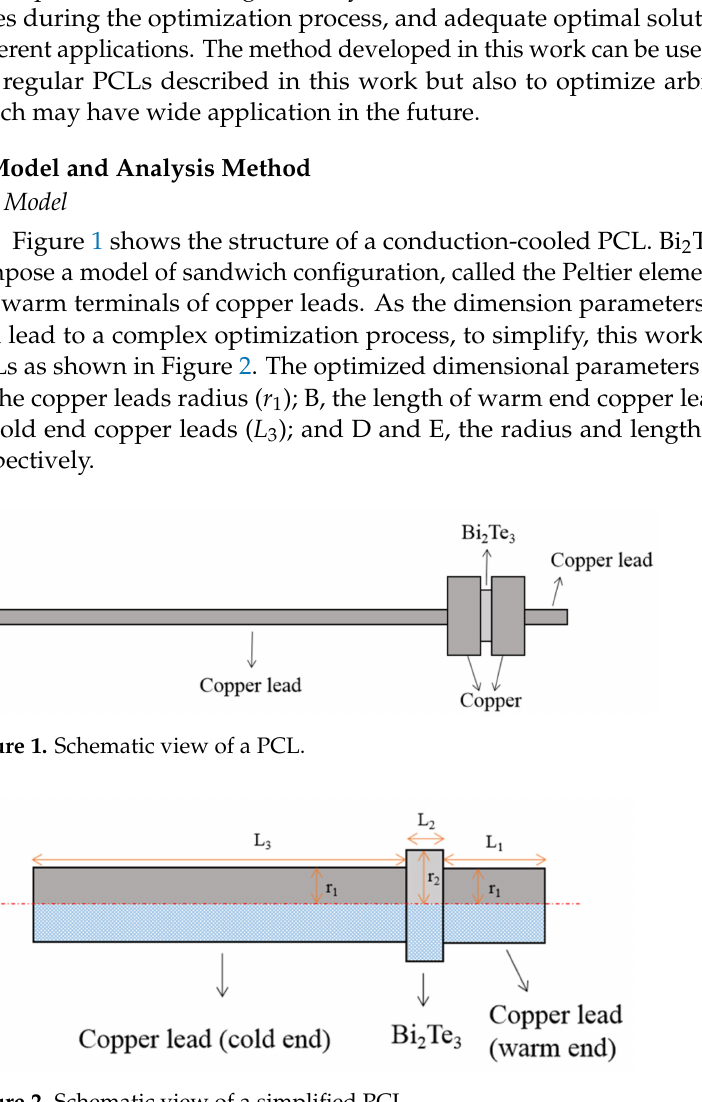
Figure 2. Schematic view of a simplified